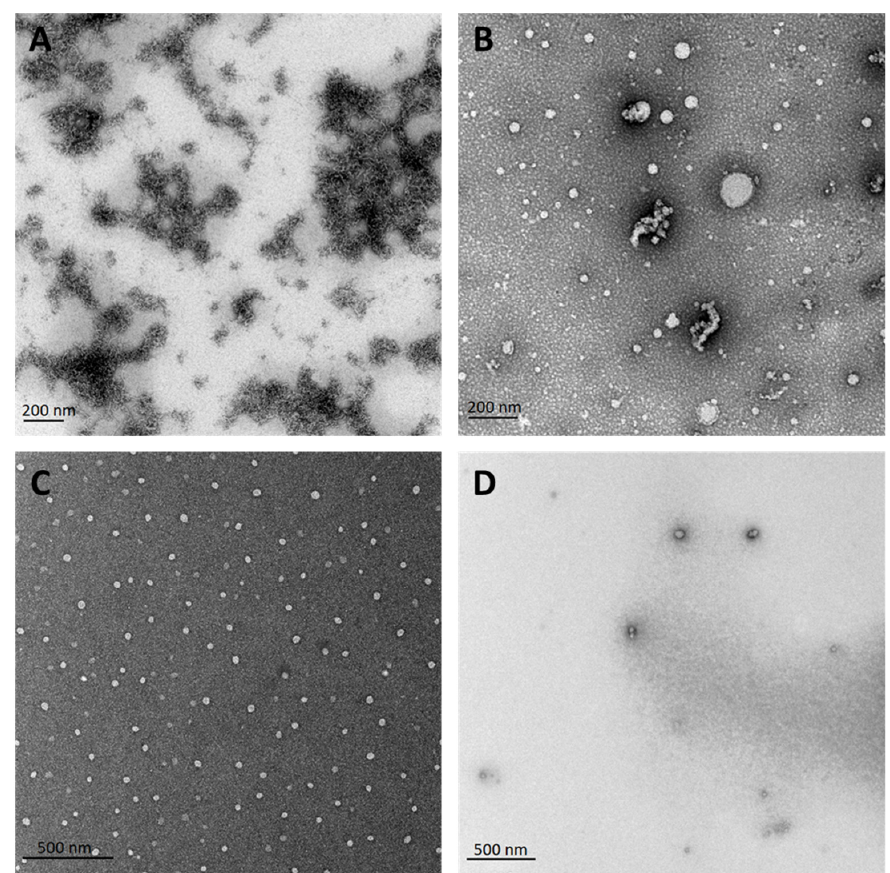
Figure 3. Morphology of particles formed by differently dissolved PF14 as analysed by TEM. The 1 mM stock solutions of PF14 were prepared by dissolving the peptide in different solvents and their mixtures: MQ water ( A ), EtOH ( B ), EtOH90/DMSO10 ( C ) or in EtOH90/DMSO9.6/TMC0.4 ( D ), and resulting particles were analysed by TEM. All proportions are given as v : v .